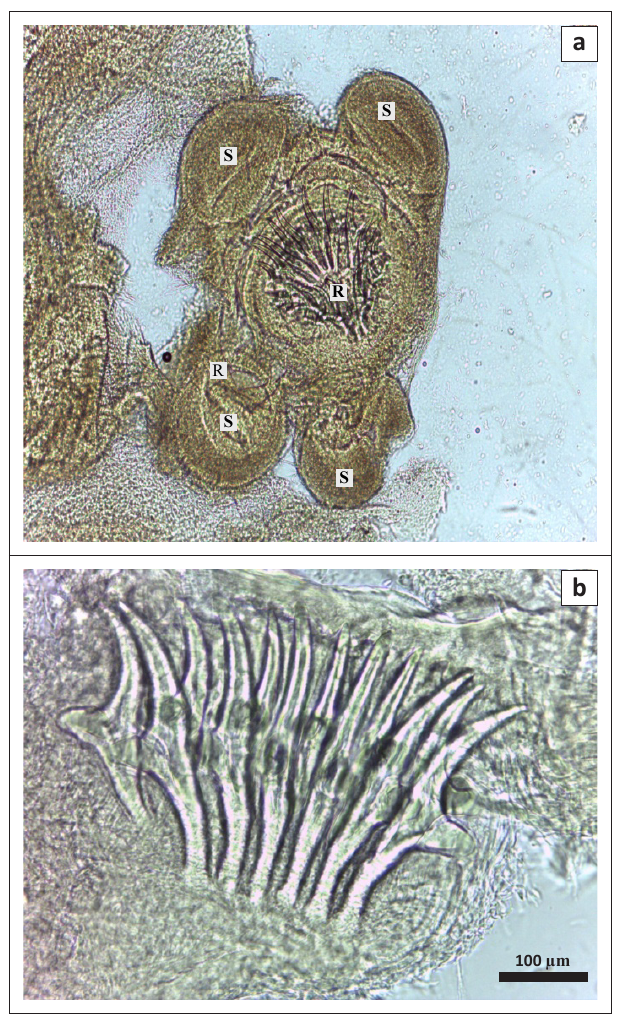
FIGURE 3: Fresh unstained sample showing typical Taenia multiceps protoscolices (a) whole mounted protoscolex (b) rosellar